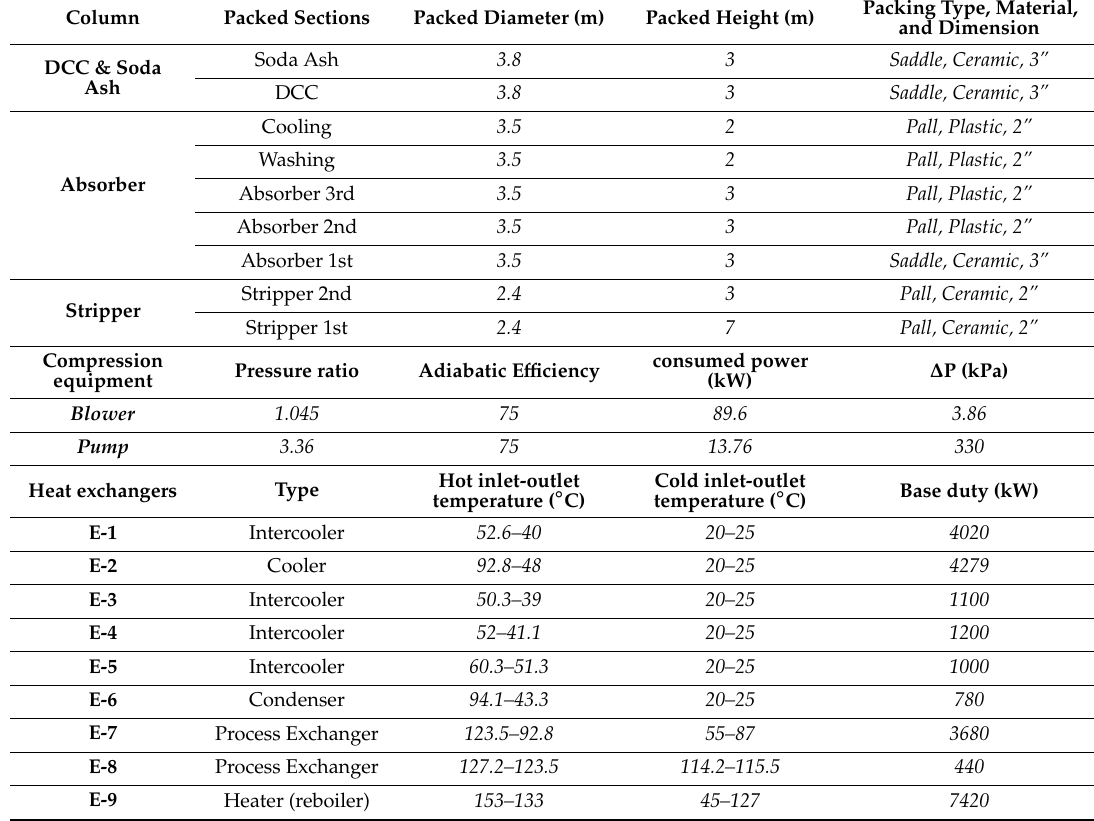
Table 4. Specification of columns’ internal, compression equipment and heat exchangers for the industrial post-combustion CO2 capture (PCC)